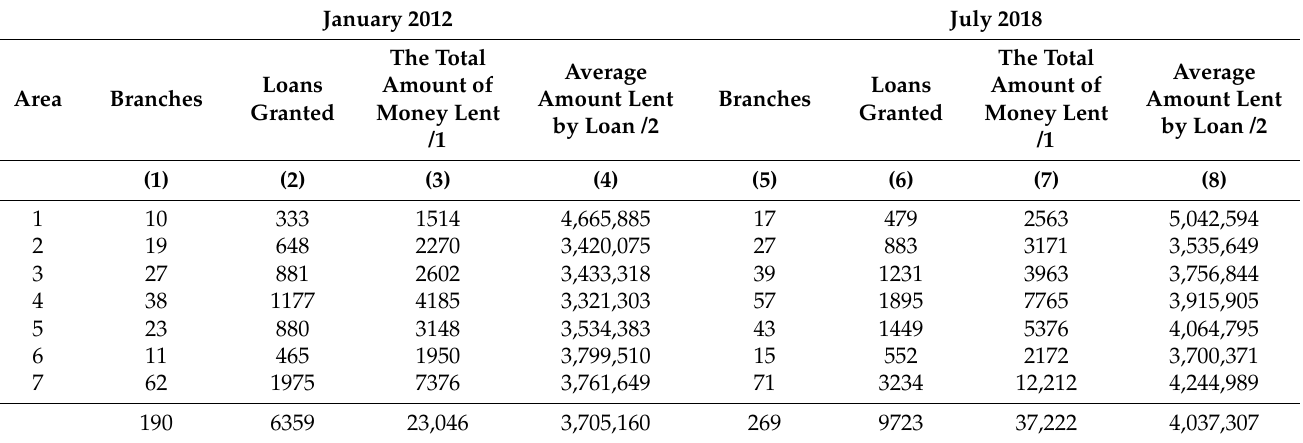
Table 2. Main Figures of the state-owned bank, Banco Estado